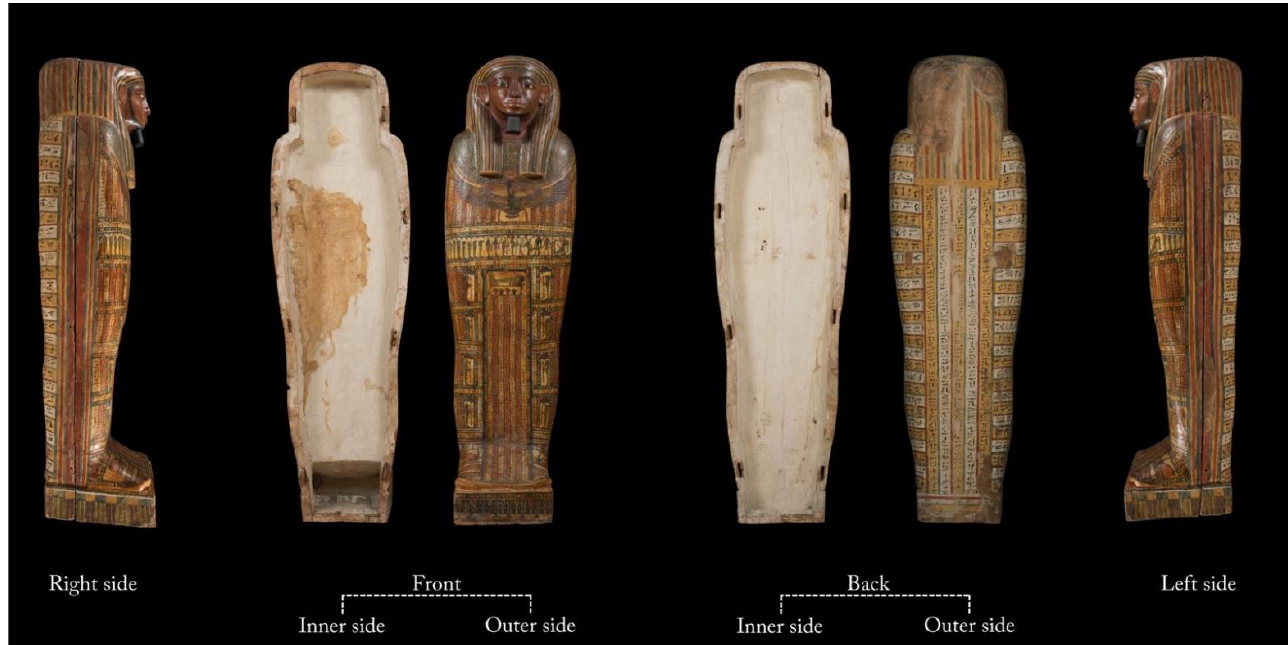
Figure 2. Head end/wall and foot board of Un- Montu’s coffin.